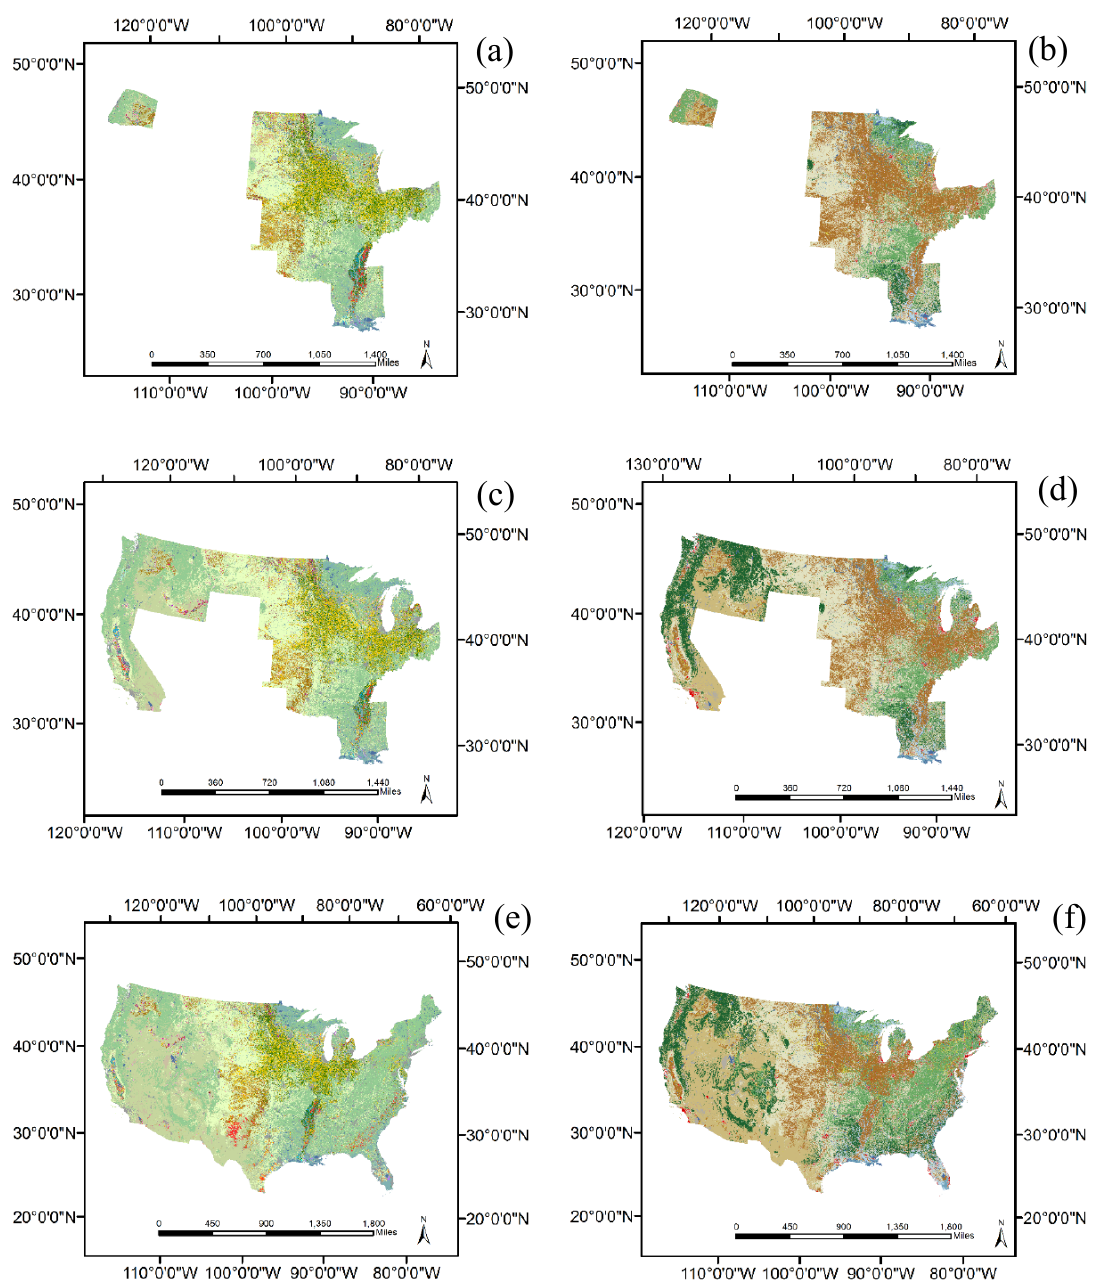
Figure 2. ( a ) National Agricultural Statistics Service (NASS) Cropland Data Layer (CDL) 2006; ( b ) CDL 2006 cross-walked; ( c ) CDL 2007; ( d ) CDL 2007 cross-walked; ( e ) CDL 2011; and ( f ) CDL 2011 cross-walked.